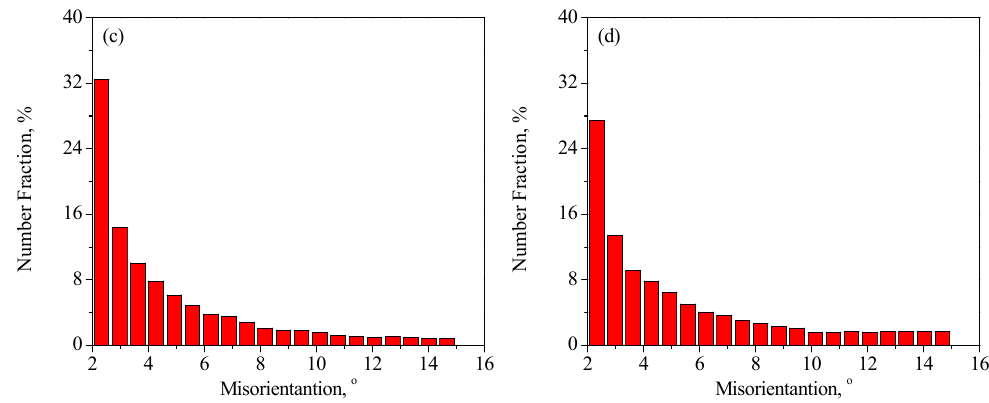
Figure 8. Distribution histograms of misorientation angles in the range 2–15 ° for the solution-treated samples deformed at different strains of ( a ) 0.2, ( b ) 0.4, ( c ) 0.6 and ( d ) 0.8.